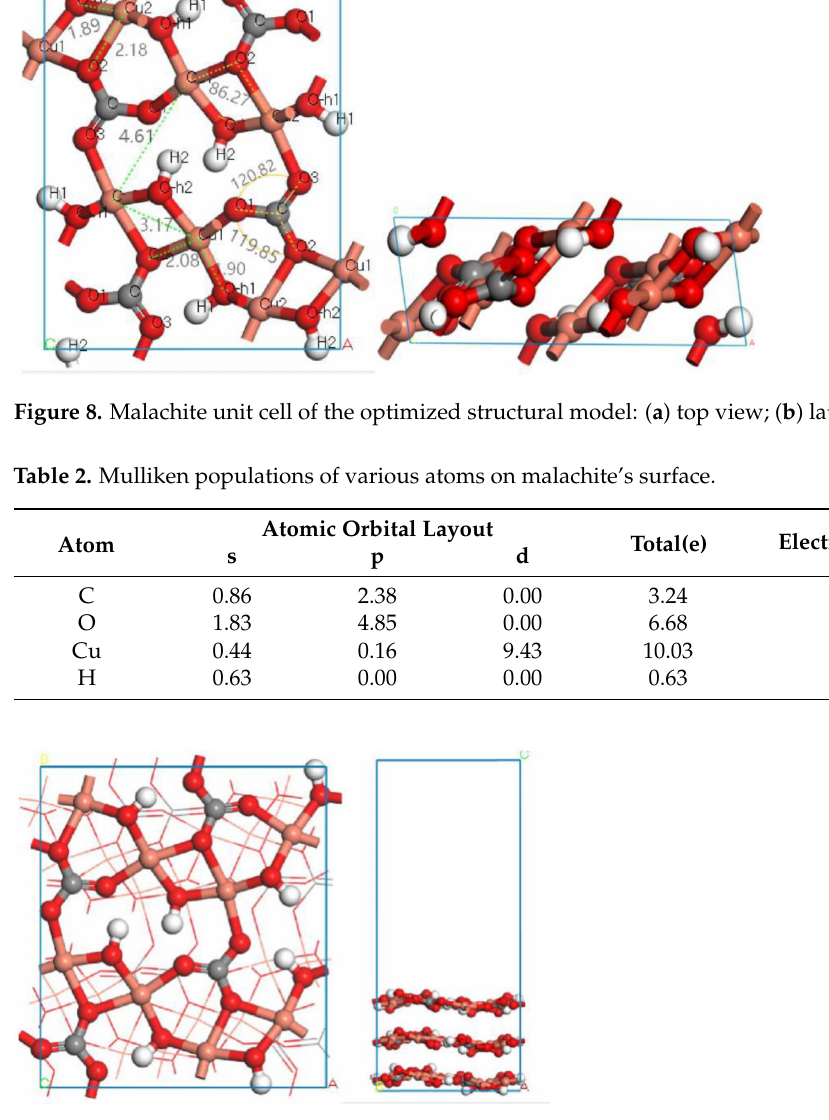
Figure 9. Optimized ( − 201) surface of malachite: ( left ) top view; ( right ) lateral view. The balls in orange, red, gray, and white colors represent copper atoms, oxygen atoms, carbon atoms, and hydrogen atoms,